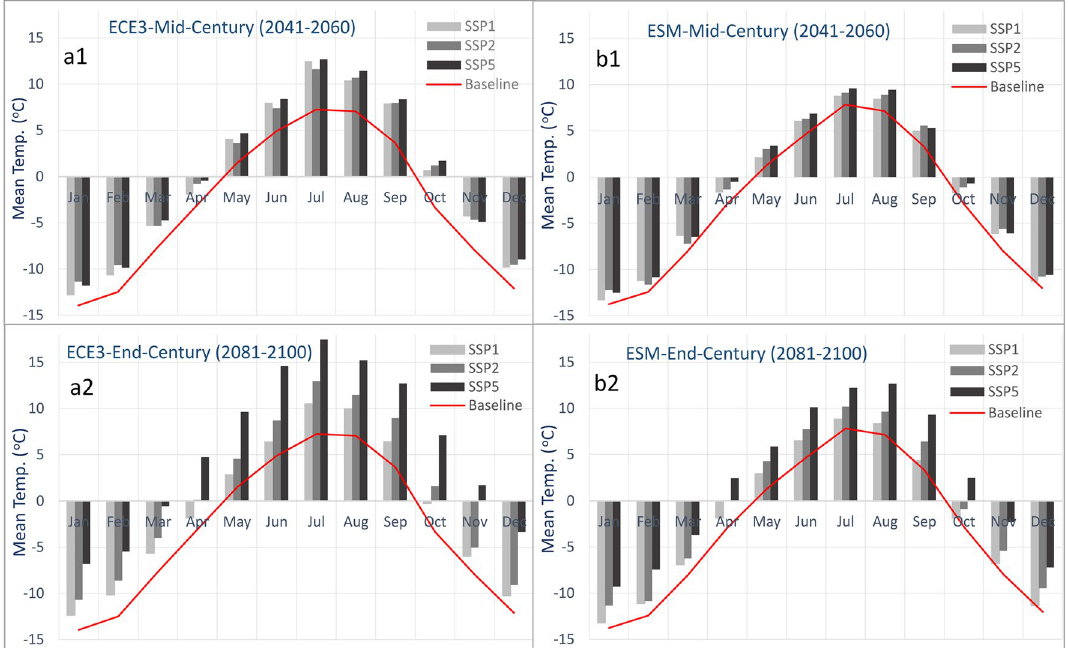
Figure 2. Mean monthly future temperature relative to the baseline period based on; ( a1 ) ECE3-mid-century, ( a2 ) ECE3-end-century, ( b1 ) ESM-mid-century, and ( b2 )